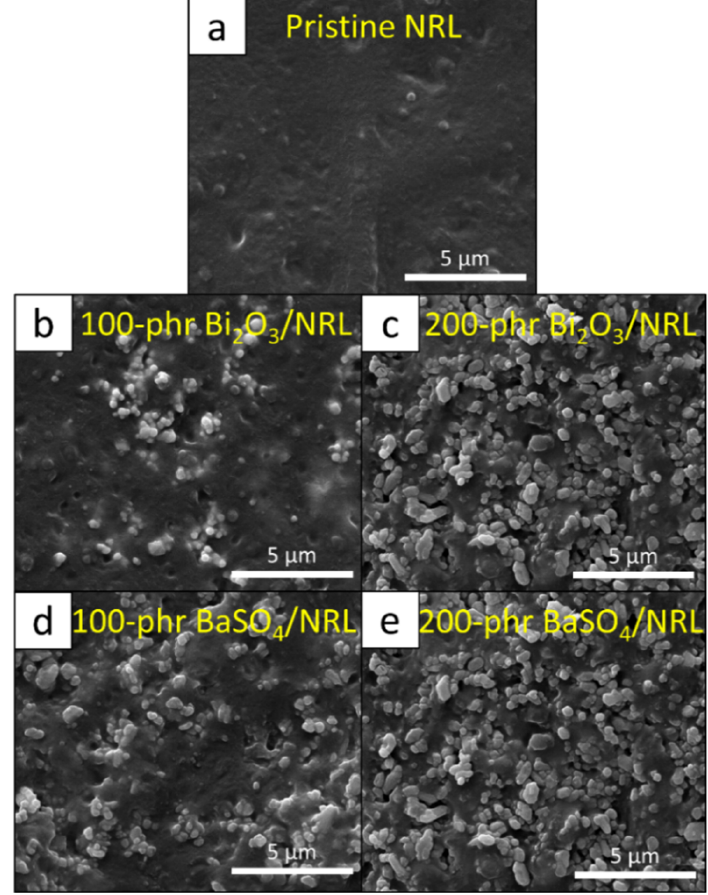
Figure 8. SEM images showing morphology and particle dispersion for ( a ) pristine SVNRL, ( b ) 200 phr Bi 2 O 3 /SVNRL, ( c ) 200 phr Bi 2 O 3 /SVNRL, ( d ) 100 phr BaSO 4 /SVNRL, and ( e ) 200 phr BaSO 4 /SVNRL composites (10,000× magnification).